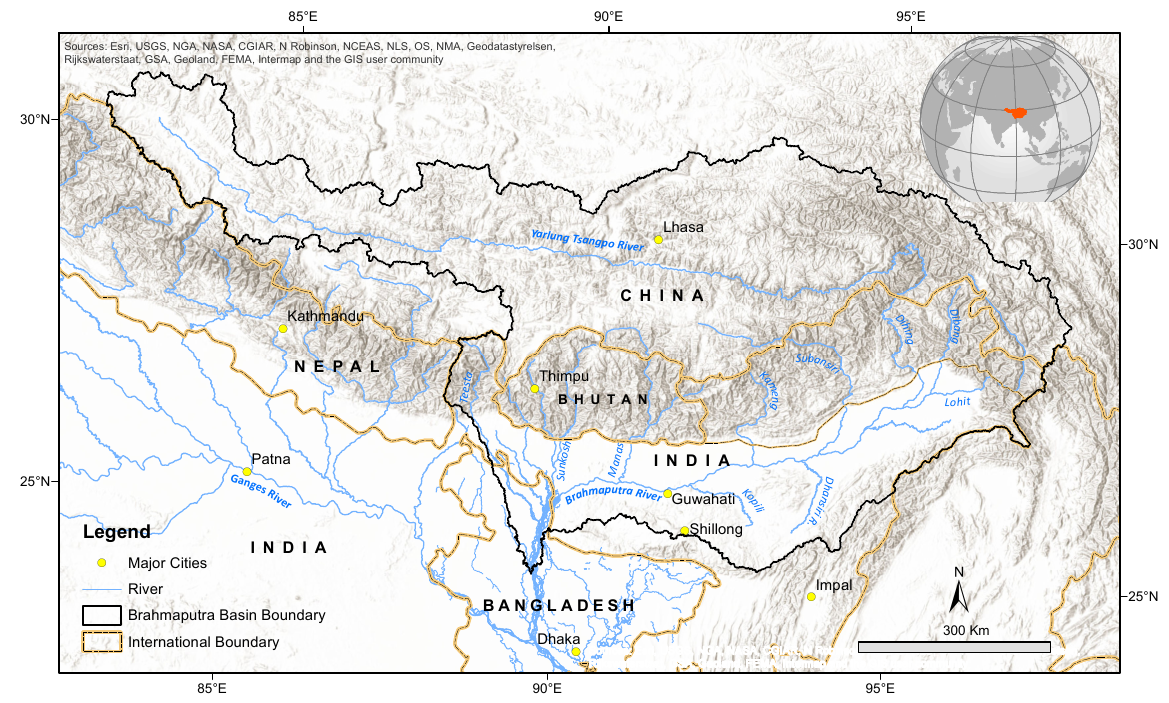
Figure 1. The Brahmaputra River Basin (map source: prepared by the authors). The basin falls into three major physiographic zones: the Tibetan Plateau (>3500 m asl, 44.4% of the total basin area), the Himalayan belt (100–3500 m asl, 28.6%), and the floodplains (<100 m asl, 27%) [25]. The basin along the Southern Himalayan slope is dominated by the South Asian monsoon, with an average annual rainfall of 1400–6000 mm (average 2300 mm). In contrast, the upper part of the basin in the Tibetan Plateau (North- ern Himalayan slope) has an average annual rainfall of only 300–1200 mm (average 750 mm) [23,26]. About 70–80% of the annual rainfall occurs during the monsoon season (June–September), 15–20% during the pre-monsoon period (April–May), and the remaining 5–10% in the post-monsoon (October–November) and winter and dry season (December– March) [26]. The average annual discharge of the Brahmaputra measured at Bahadurabad in Bangladesh, i.e., the gauging station furthest downstream, is about 20,200 m 3 s − 1 , and the average peak flood discharge is 70,000 m 3 s − 1